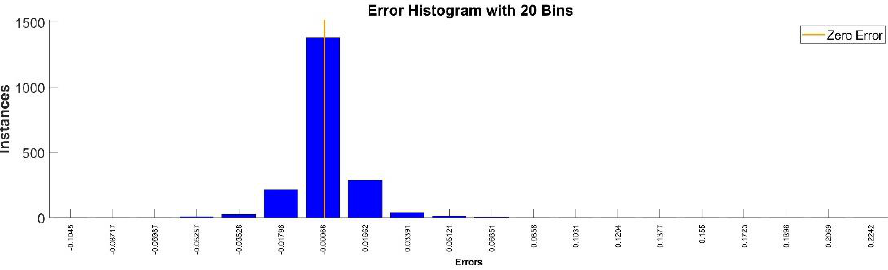
Figure 26. Error histogram between the target values and the estimated values for 𝑞 5 .